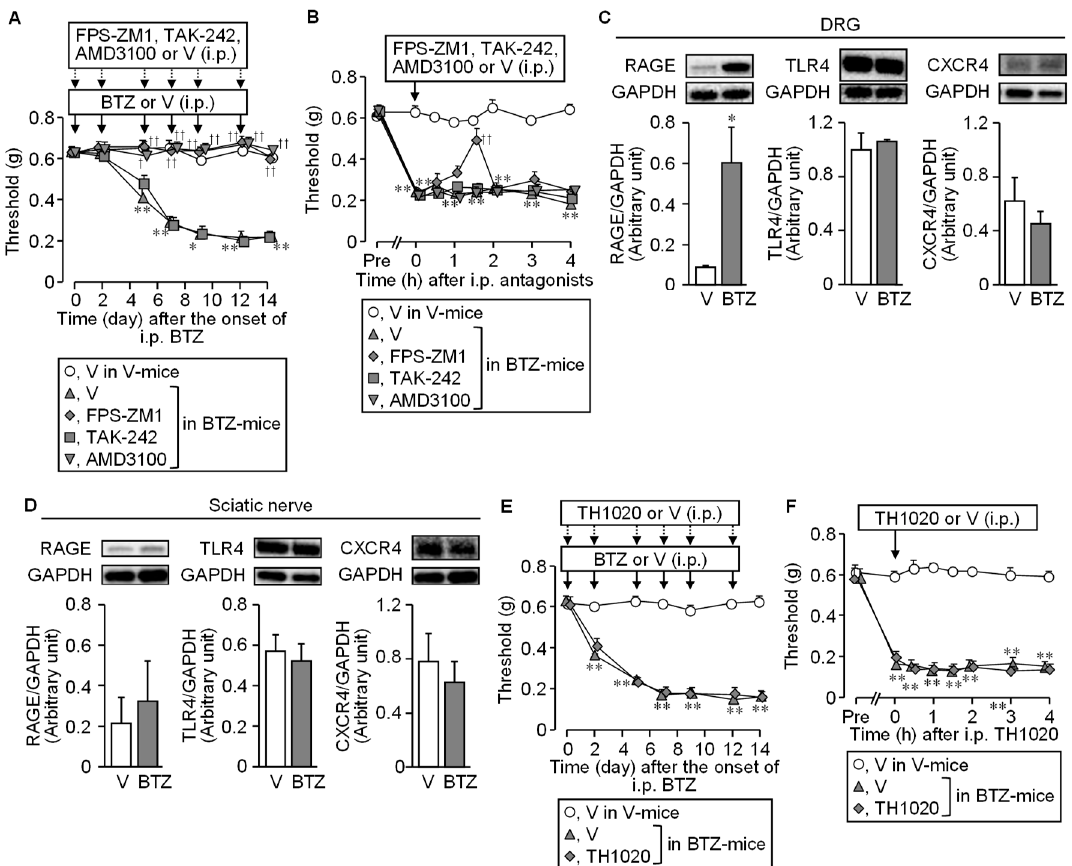
Figure 3. Involvement of HMGB1-targeted receptors in the CIPN caused by bortezomib. Bortezomib at 0.4 mg/kg or vehicle was administered i.p. on days 0, 2, 5, 7, 9, and 12. ( A , B ) Preventive ( A ) or therapeutic ( B ) effect of FPS-ZM1, TAK-242, and AMD3100, antagonists of RAGE, TLR4, and CXCR4, respectively. The mice received repeated i.p. administration of FPS-ZM1 at 1 mg/kg, TAK-242 at 3 mg/kg, AMD3100 at 8 mg/kg, or vehicle, 30 min before each dose of bortezomib ( A ), or single i.p. administration of each of them on day 14 ( B ). ( C , D ) Protein levels of RAGE, TLR4, and CXCR4 in the dorsal root ganglion ( C ) and sciatic nerves ( D ) on day 14 after the onset of bortezomib treatment. ( E , F ) Lack of preventive ( E ) and therapeutic ( F ) effects of TH1020, a TLR5 antagonist. The mice received repeated ( E ) or single ( F ) i.p. administration of TH1020 at 1 mg/kg or vehicle, in mice treated with bortezomib according to the above-mentioned schedules. Data show the mean with S.E.M for 5–6 ( A , B , F ), 5–7 ( C ), 6–7 ( D ), or 6 ( E ) mice. V, vehicle; BTZ, bortezomib; DRG, dorsal root ganglion; * p < 0.05, ** p < 0.01 vs. V ( C ) or V in V-treated mice ( A , B , E , F ). † p < 0.05, †† p < 0.01 vs. V in BTZ-treated mice.